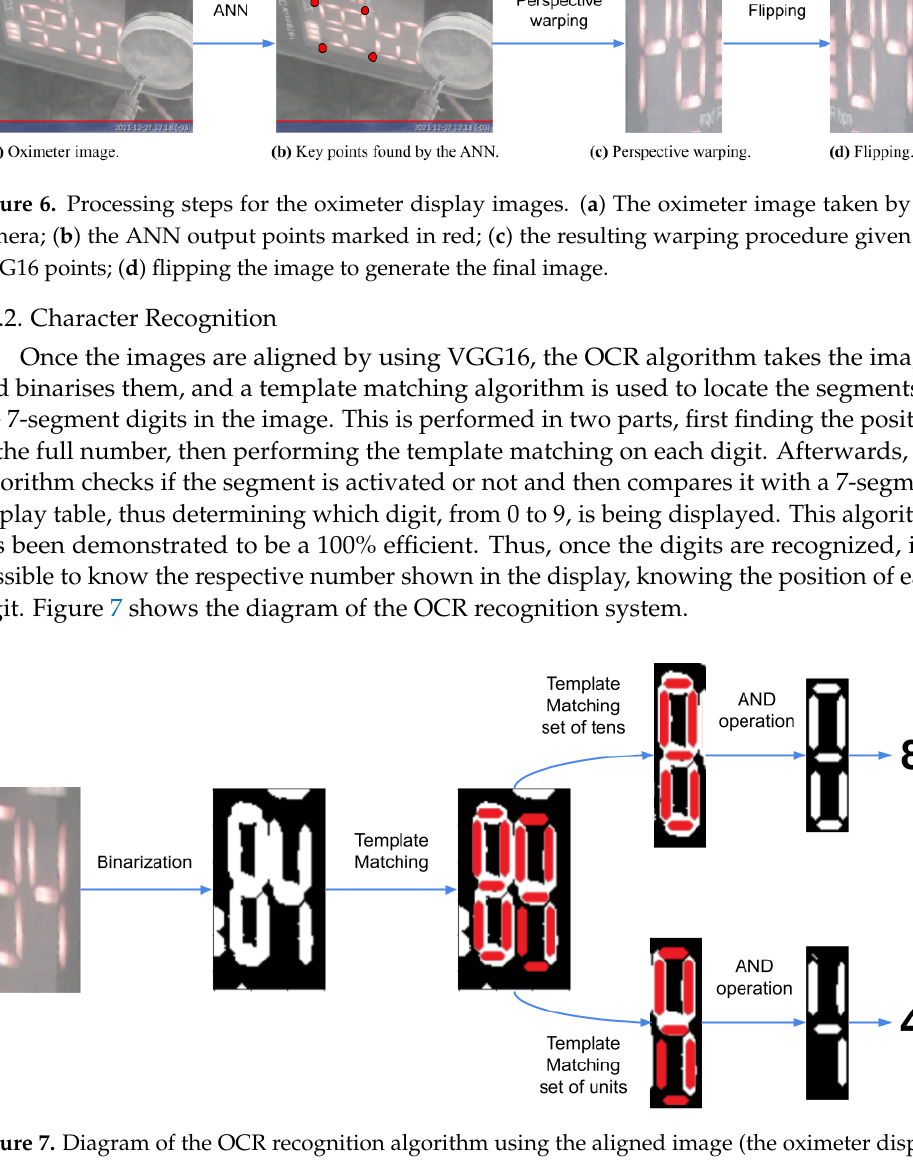
Figure 7. Diagram of the OCR recognition algorithm using the aligned image (the oximeter display in this example) to search for key pixels applying template matching and return the displayed value in text